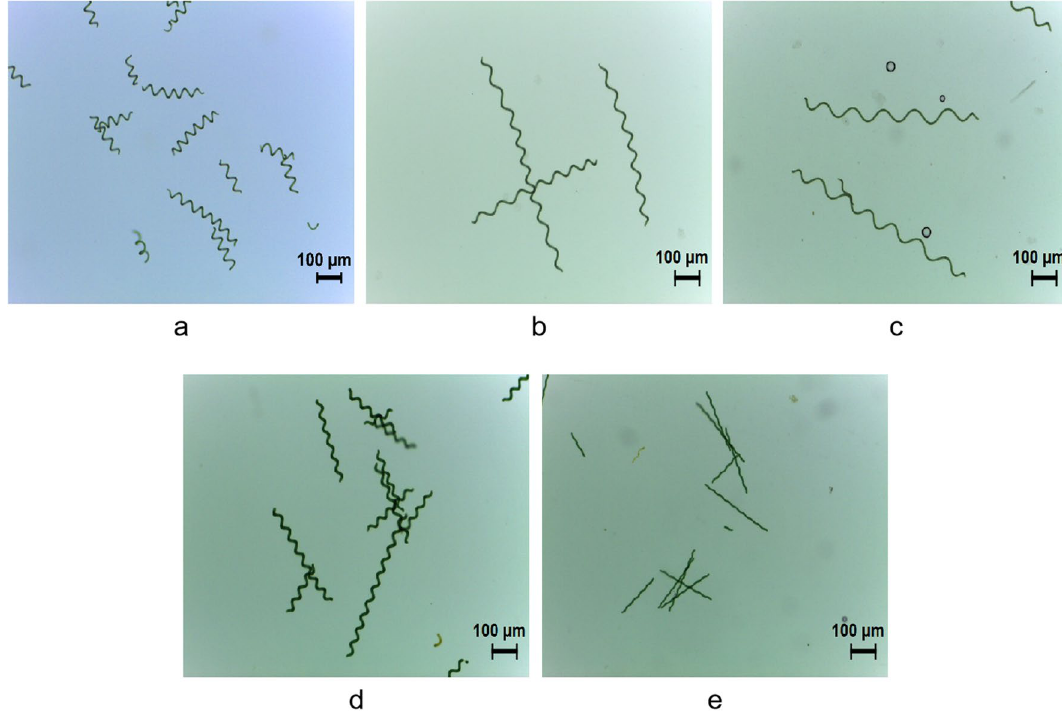
Figure 3. Photomicrographs of the five Arthrospira strains. ( a ) sp.HS; ( b ) sp.DD; ( c ) sp.QD; ( d ) sp.ER; ( e )